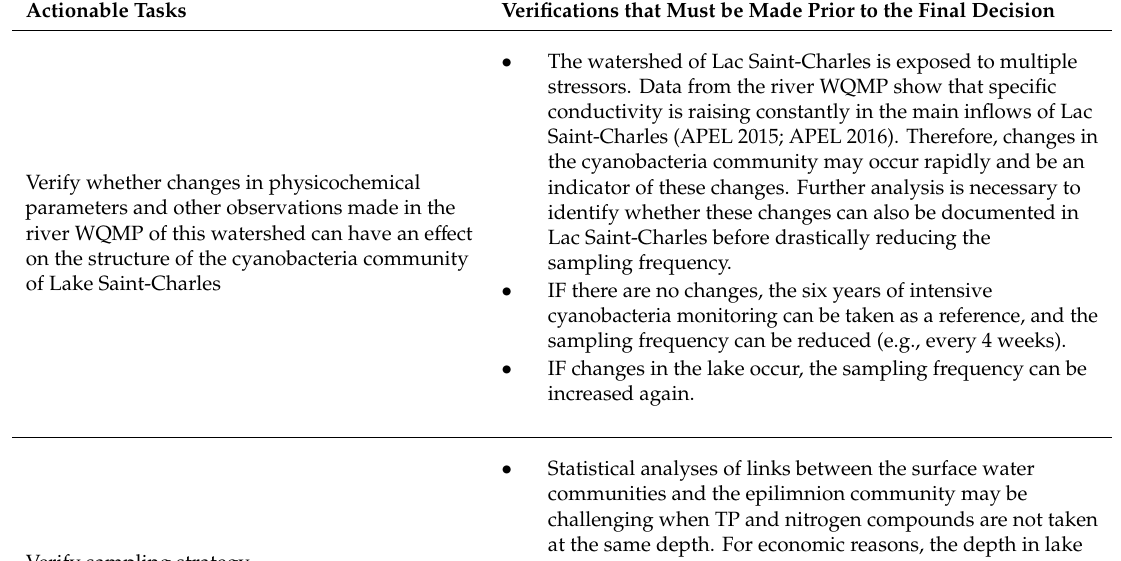
Table 1. Summary of the actionable tasks to take final decisions for the optimization of the W1 WQMP. Actionable